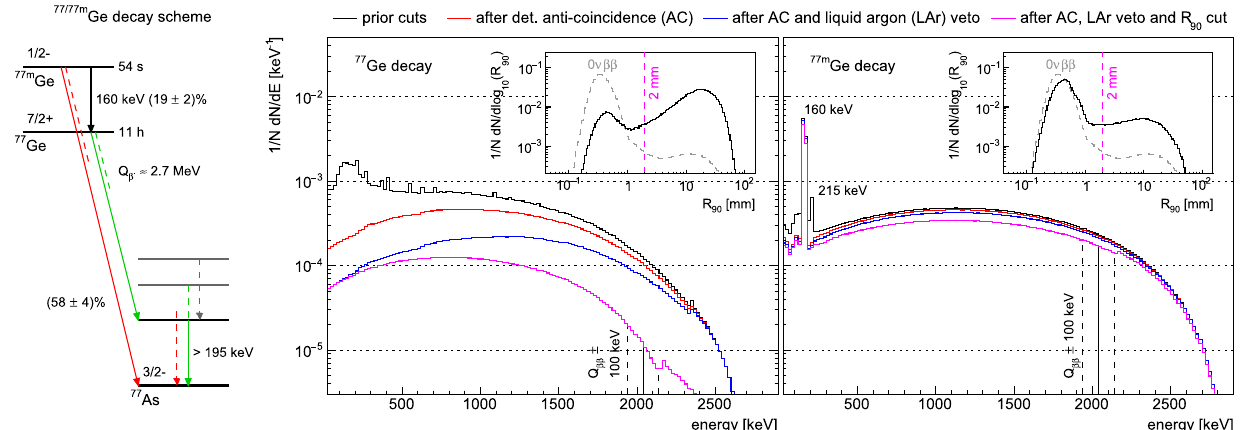
Fig. 1 Left: simplified decay scheme for 77 Ge and 77 m Ge. Both iso- topes undergo β -decay to 77 As. 77 m Ge undergoes mainly pure ground- state decay without the release of coincident γ ’s. Middle/right: spectra for 77 Ge and 77 m Ge decays in enriched detectors of Gerda PhaseII.